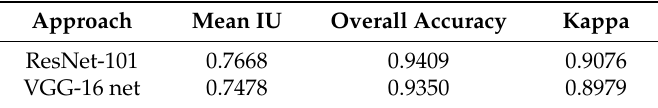
Table 4. Experimental results of different baseline architectures.